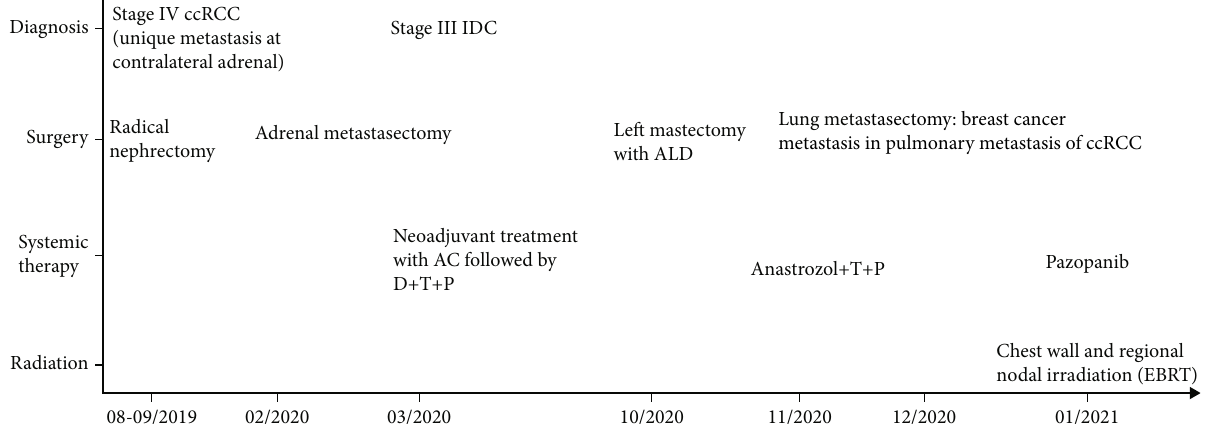
Stage IV ccRCC Diagnosis (unique metastasis at